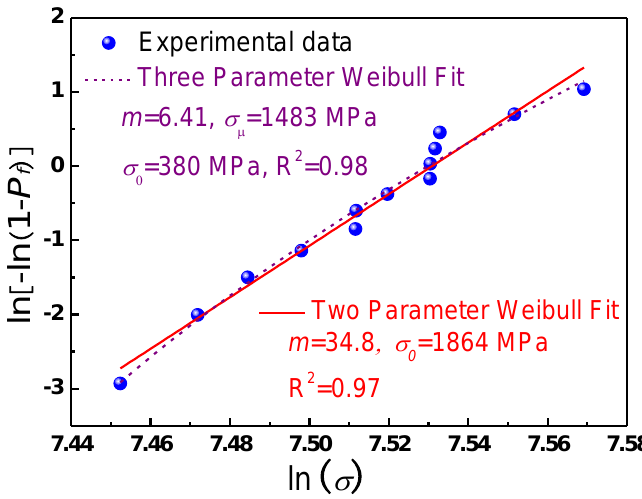
Figure 6. Two- and three-parameter Weibull distribution fitting curve of Cu 48 Zr 48 Al 4 amorphous microwires’ fracture strength.